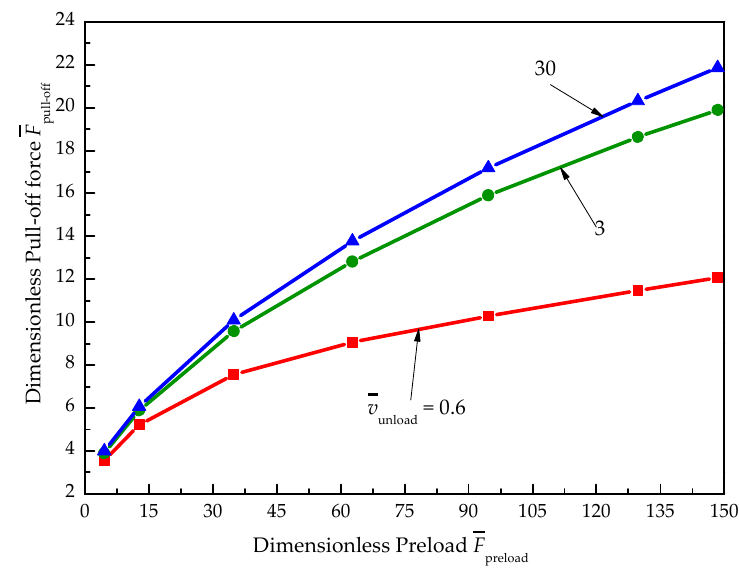
Figure 8. The effect of preload on pull-off force under the condition of Δ𝛾̅ = 0.05.